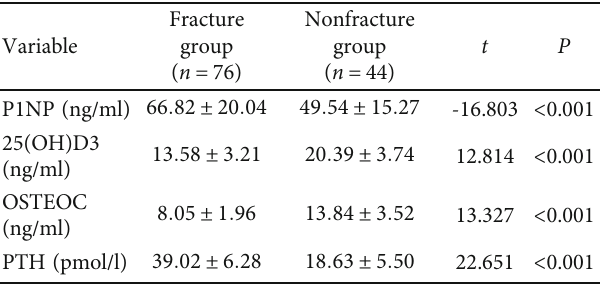
Table 3: Comparison of biochemical indexes of bone metabolism between the two groups.